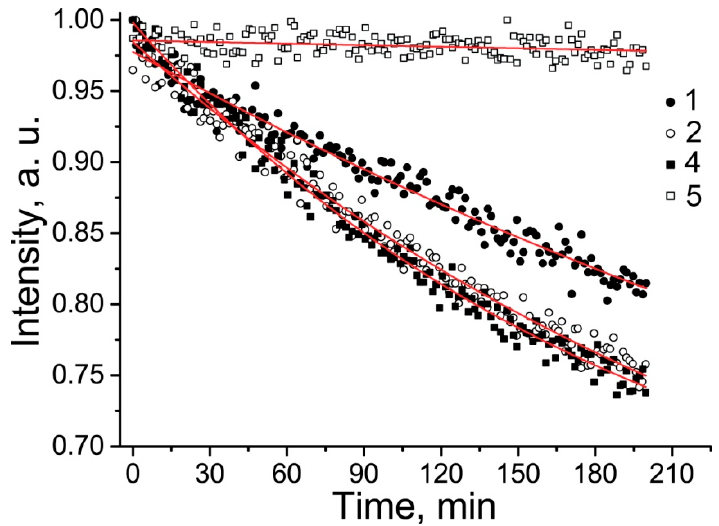
Figure 3. Kinetics of 1 , 2 , 4 , and 5 decay in the presence of 0.5 M ascorbate in 50% methanol at pH 7.4. Solid curves are simulation via a monoexponent with parameters shown in Table 1.